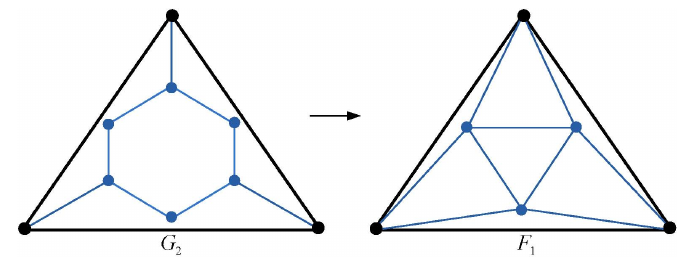
Fig. 2. The transformation from G 2 to F 1 .